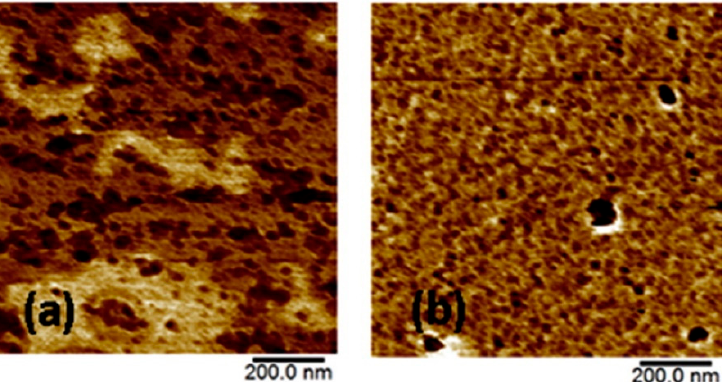
Figure 9. AFM images of hybrid nanocoating composite in 24 h salt spray studies for non ‐ functionalized ( a ) and functionalized silica coating ( b ) [91].